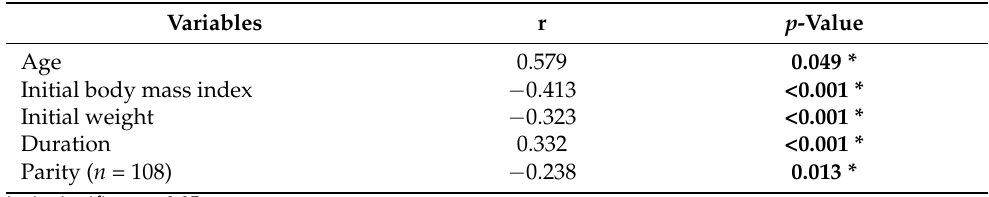
Table 4. Correlation of different variables with excess weight loss.